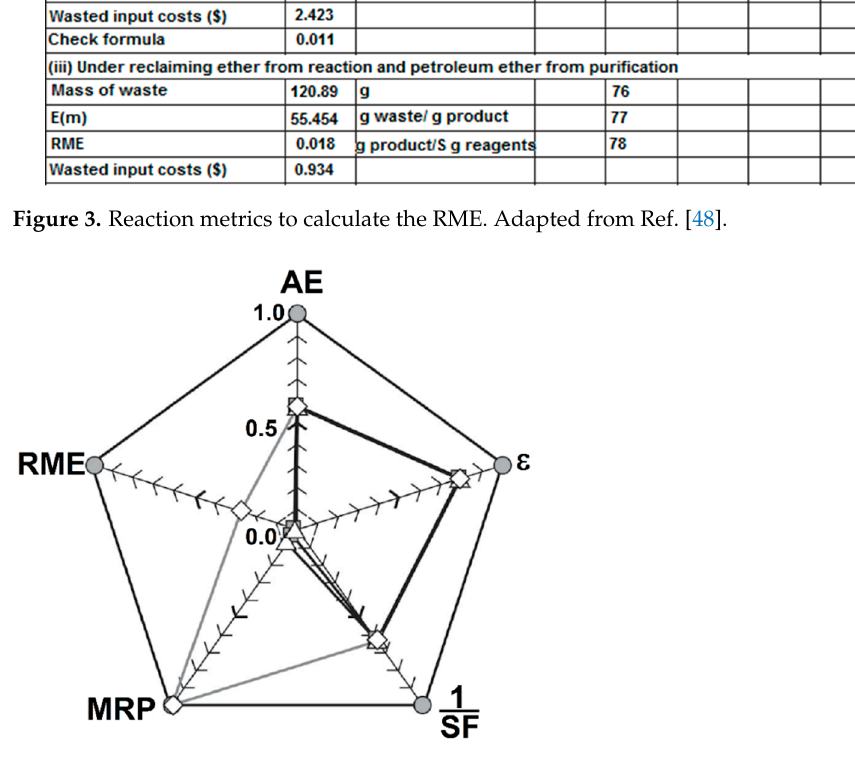
Figure 4. RME metric values represented by radial pentagon. Adapted from Refs. [48,71].